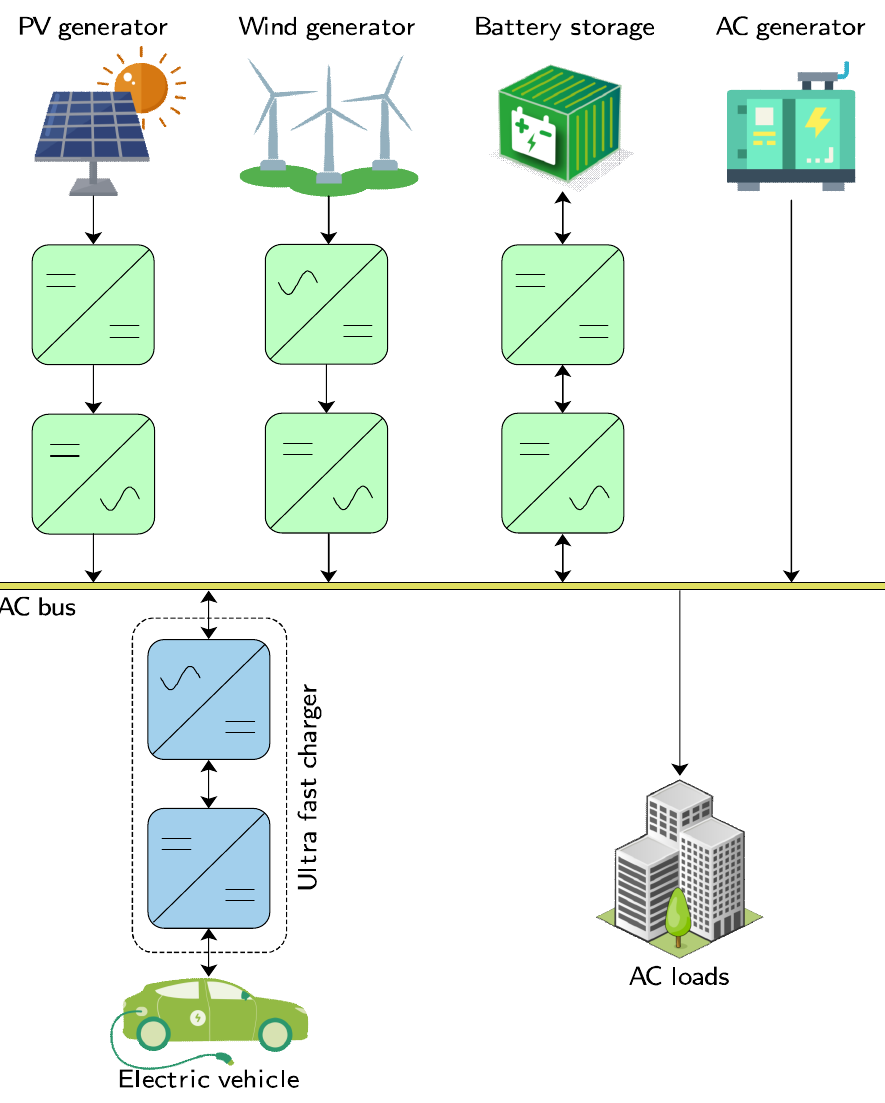
Figure 14. The ultra-fast charging station in AC standalone microgrid.